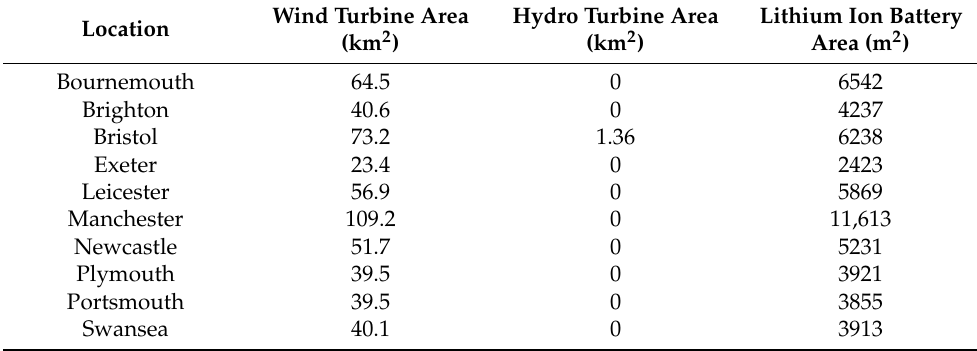
Table 13. Required areas for system